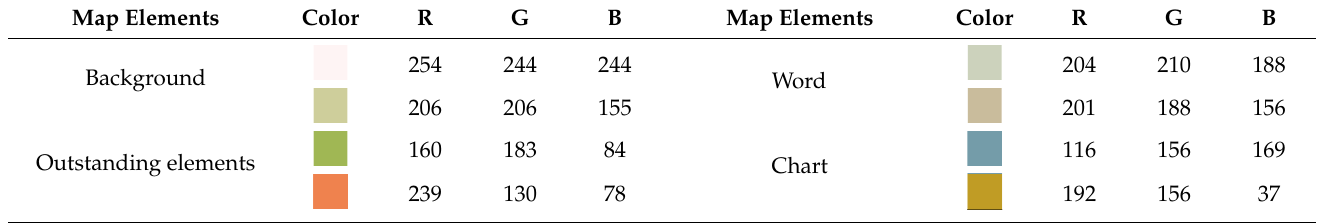
( d ) Figure 6. Layout settings for the layout system: ( a ) famous buildings layout; ( b ) famous products layout; ( c ) traditional customs layout; ( d ) famous people and events layout. 3.2.2. Follow the Map Design Principle of Figurativeness and Symbolism (1) Color System Visualization ‐ narrative research considers color to have the same narrative function as language and text [11]. The establishment of the color system of map design in this study was based on the principle of figurativeness and symbolism, and the main colors used in the map were determined around the iconic features of Dengfeng [46,47]. Among them, the buildings and landscapes (e.g., Shaolin Temple, Stargazer Terrace, etc.), which are symbols of the city, have strong local characteristics, and adopting their main colors, such as red and brown, can better reflect the culture and temperament of the city [23]. At